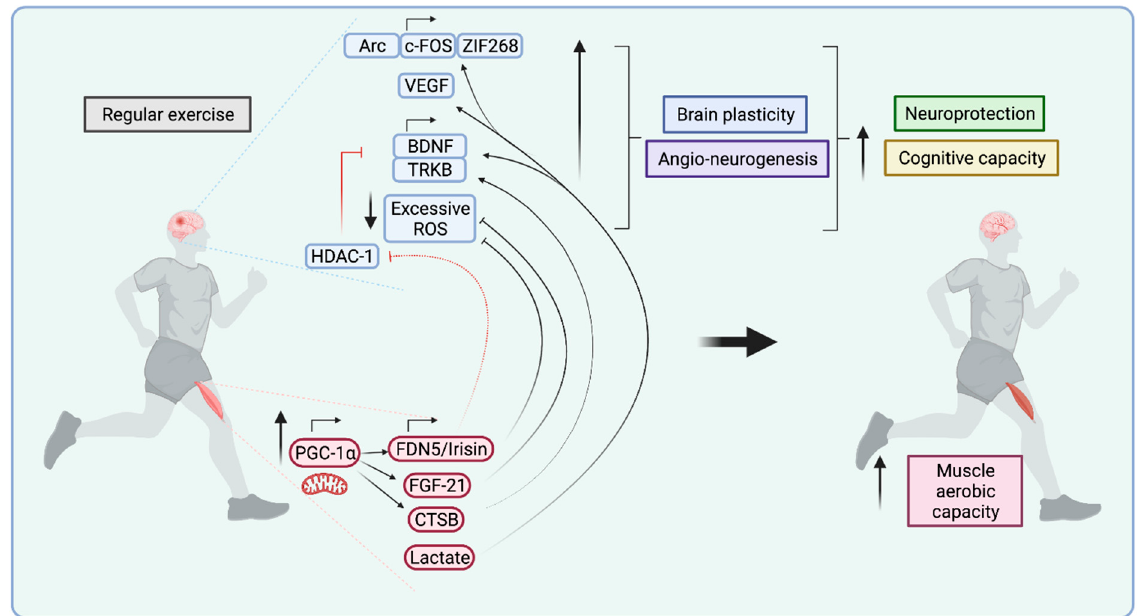
Figure 2. Exercise-induced neuroprotection through circulating myokines. Exercise induces increased peroxisome-proliferator-activated receptor γ coactivator-1 α (PGC-1 α ) expression and supports induction of different myokines such as FDN5/Irisin, cathepsin B (CTSB), fibroblast growth factor 21 (FGF21), and lactate. FDN5/Irisin induces brain-derived neurotrophic factor (BDNF) expression in the brain through indirect inhibition of histone deacetylase 1(HDAC-1). Several of these factors increase signalling of BDNF and its receptor Tropomyosin receptor kinase B (TRKB), or reduce excessive reactive oxygen species (ROS) production. In addition, lactate increases the expression of the vascular endothelial growth factor (VEGF) and of the synaptic plasticity genes: Arc, c-FOS and ZIF268.